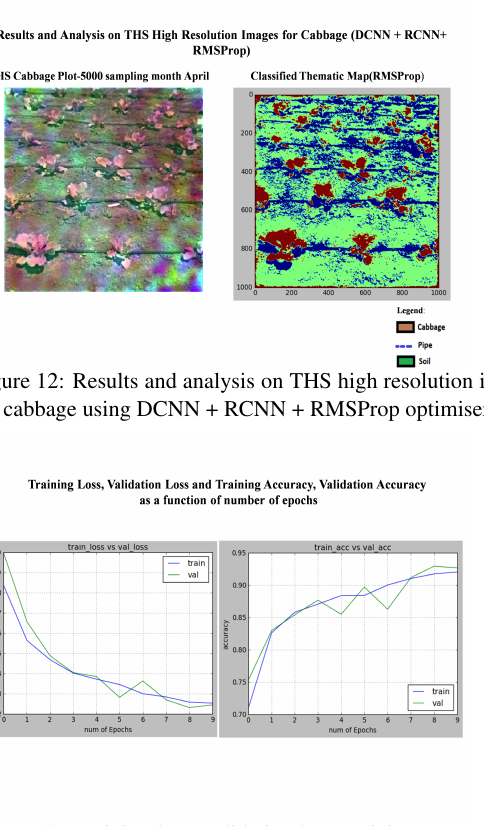
Figure 13: Training loss, validation loss, training accuracy, vali- dation accuracy as function of number of iterations and epochs